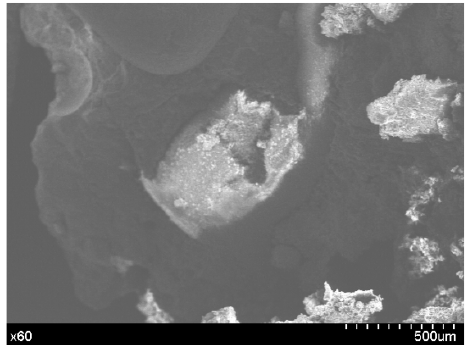
Figure 7. Morphology of the damaged microcapsules in the concrete.